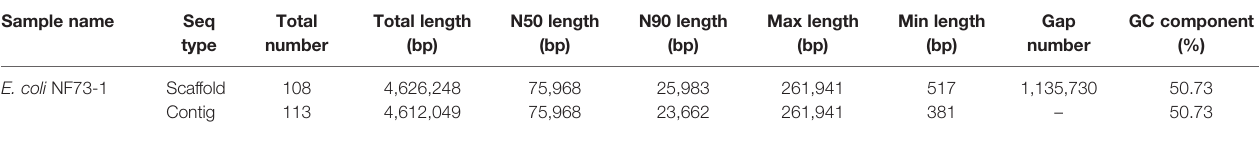
TABLE 4 | Genomic assembly information of E.coli